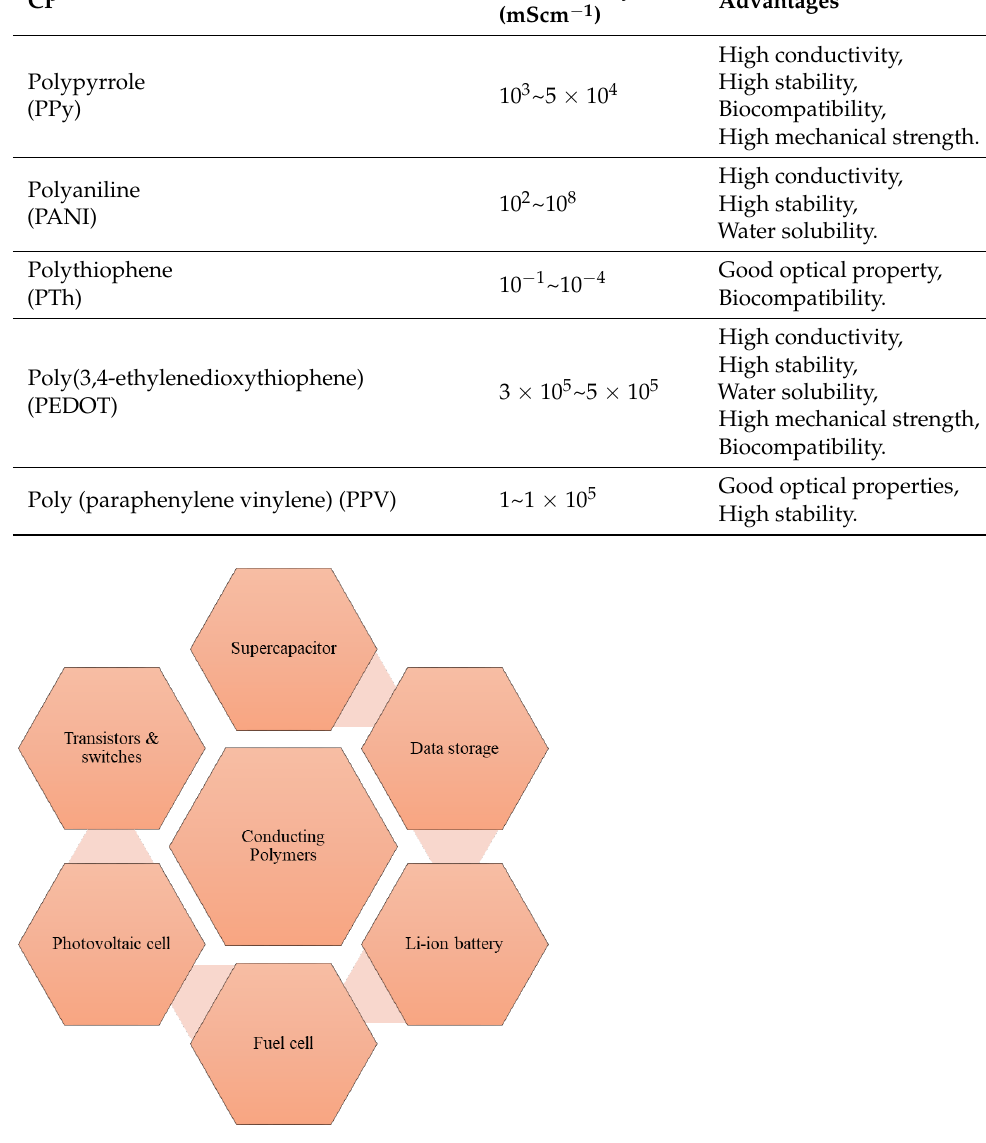
Figure 3. Applications of conducting polymers.